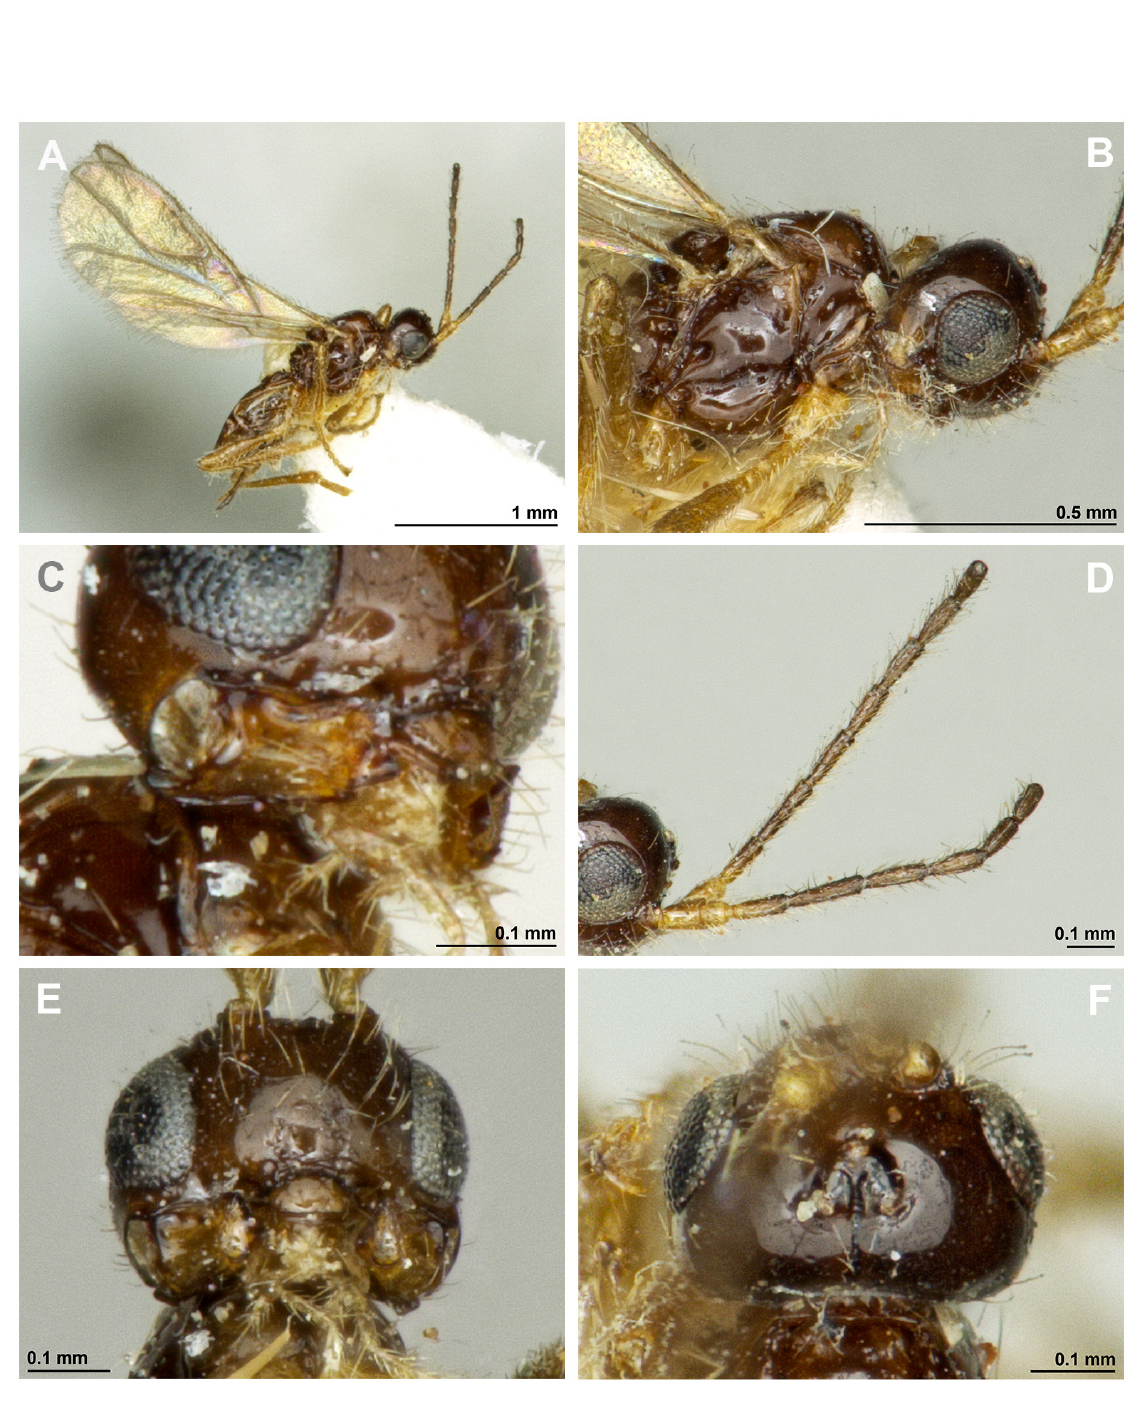
Fig. 46. Asobara notleyi Peris-Felipo, sp. nov., ♀, holotype (BMNH). A . Habitus, lateral view. B . Head and mesosoma, lateral view. C . Mandible. D . Antenna. E . Head, front view. F . Head, dorsal